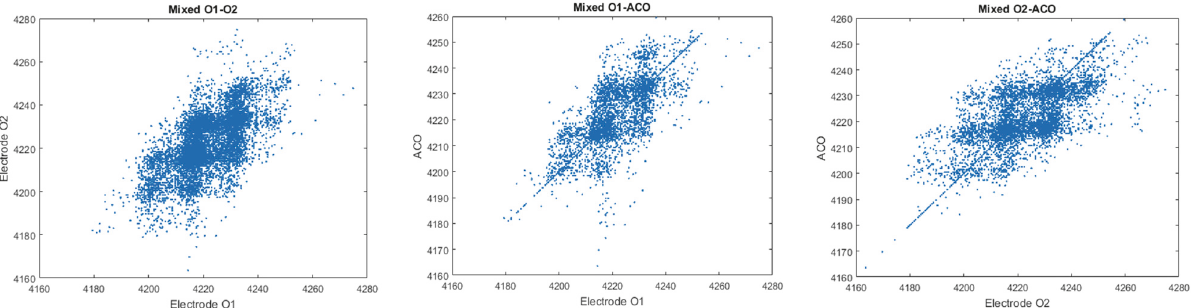
Figure 22: Representation of the mixtures of the original signals.